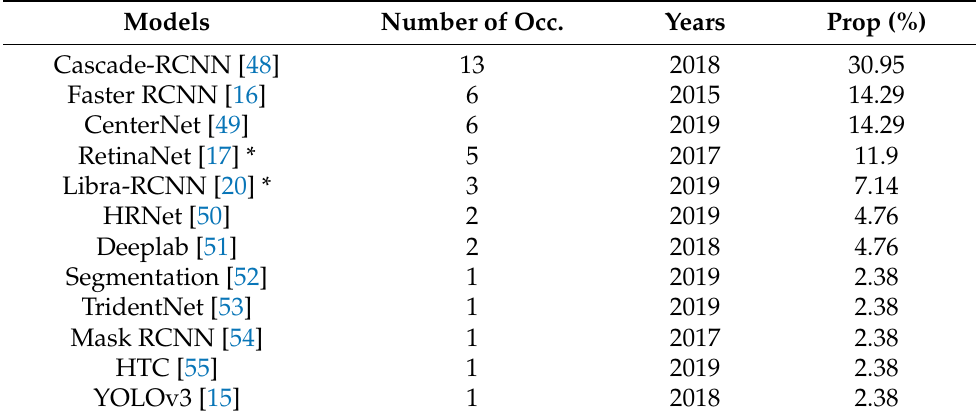
Table 7. The number of occurrences (Occ.) of 12 basic models among the 33 methods in [44]. The method with * indicates that it has been compared in Section 3.5.3.